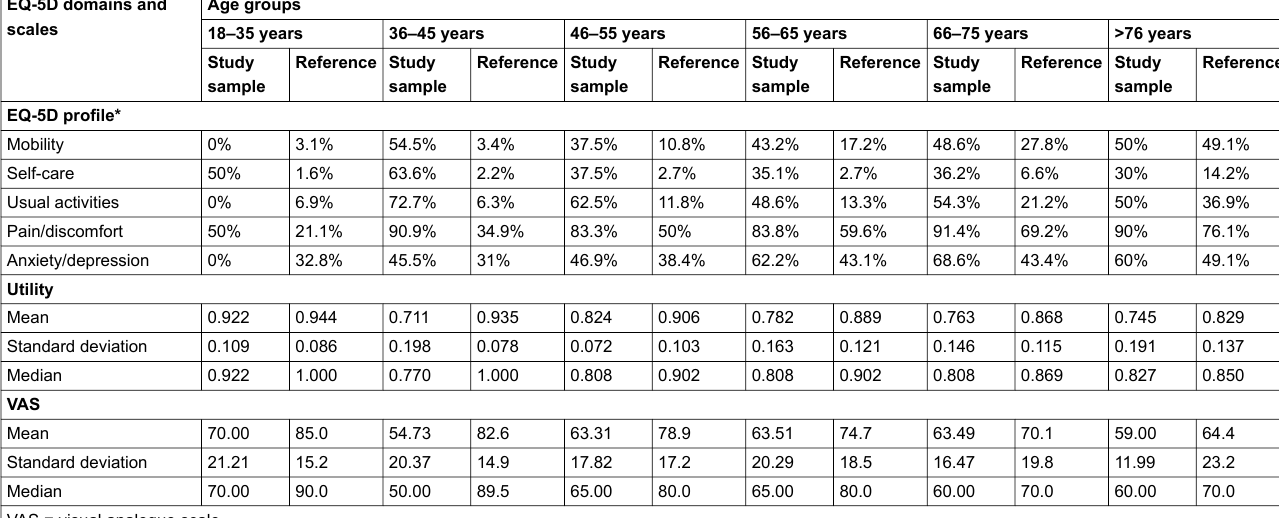
Table 3: Health-related quality of life by age group: comparison of systemic sclerosis patients with the Italian general female population reference data. Age